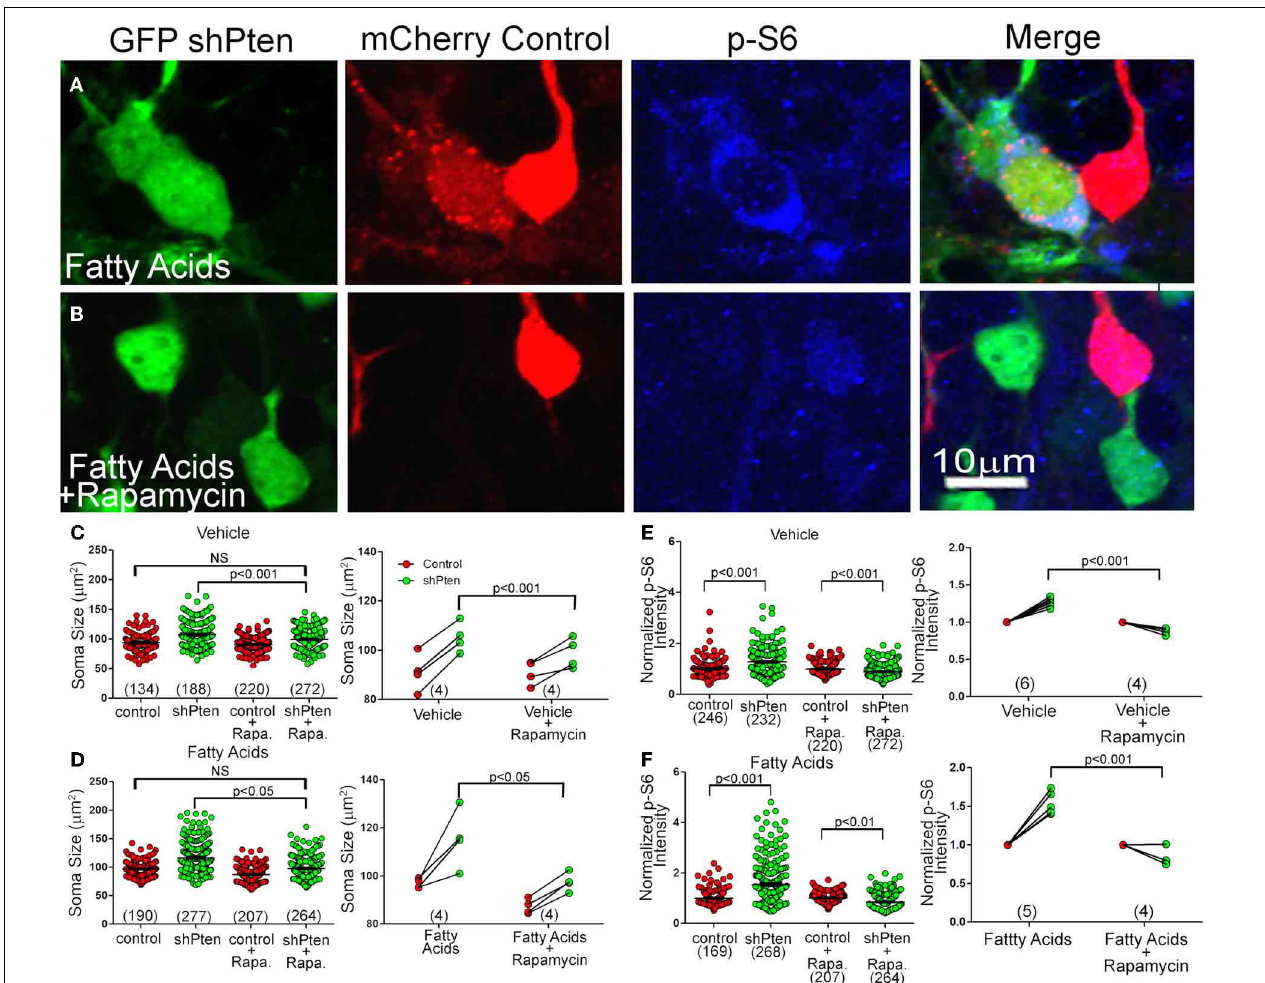
FIGURE 6 | Rapamycin Inhibits Neuronal Hypertrophy and Increased p-S6 signaling Caused by Pten Knockdown (A) Pten knockdown neurons treated with fatty acids (green) have an increase in soma size and p-S6 intensity (blue) compared to neighboring control neurons (red). (B) Treating these fatty acid exposed, Pten knockdown neurons with rapamycin (green) inhibits this increase in soma size and increase in p-S6 staining (blue) compared to control neurons (red). (C) In vehicle treated neurons, there is still an increase in soma size when comparing the knockdown neurons to control neurons (Vehicle control = 94 . 13 ± 1 . 36, Vehicle shPten = 107 . 4 ± 1 . 52, p < 0 . 001, n = 134 and 188 neurons from 4 animals). There is also still an increase in soma size when comparing the knockdown neurons to the control neurons in the rapamycin treated cells (Veh control + rapa = 91 . 03 ± 0 . 86, Veh shPten + rapa = 99 . 36 ± 1 . 00 , p < 0 . 001, n = 220 and 272 cells from 4 animals). However, there is no difference between the Veh shPten + rapa cells and the Veh control cells ( p > 0 . 05), showing that rapamycin was able to rescue the soma size of knockdown cells to that of the untreated controls. There is also a significant difference between Veh shPten cells and the Veh shPten + rapa cells ( p < 0 . 001, right panel), demonstrating that rapamycin treatment reduced the size of Pten knockdown neurons. (D) Like the vehicle, there is also still a significant increase in soma size in fatty acid treated Pten knockdown neurons compared to their controls in the rapamycin treated and non-treated groups (FA control = 96 . 86 ± 1 . 04, FA shPten = 116 . 6 ± 1 . 50, p < 0 . 001, n = 190 and 277 neurons from 4 animals; FA control + rapa = 87 . 23 ± 0 . 94, FA shPten + rapa = 97 . 38 ± 1 . 23, p < 0 . 001, n = 207 and 264 neurons from 4 animals). There was no significant difference